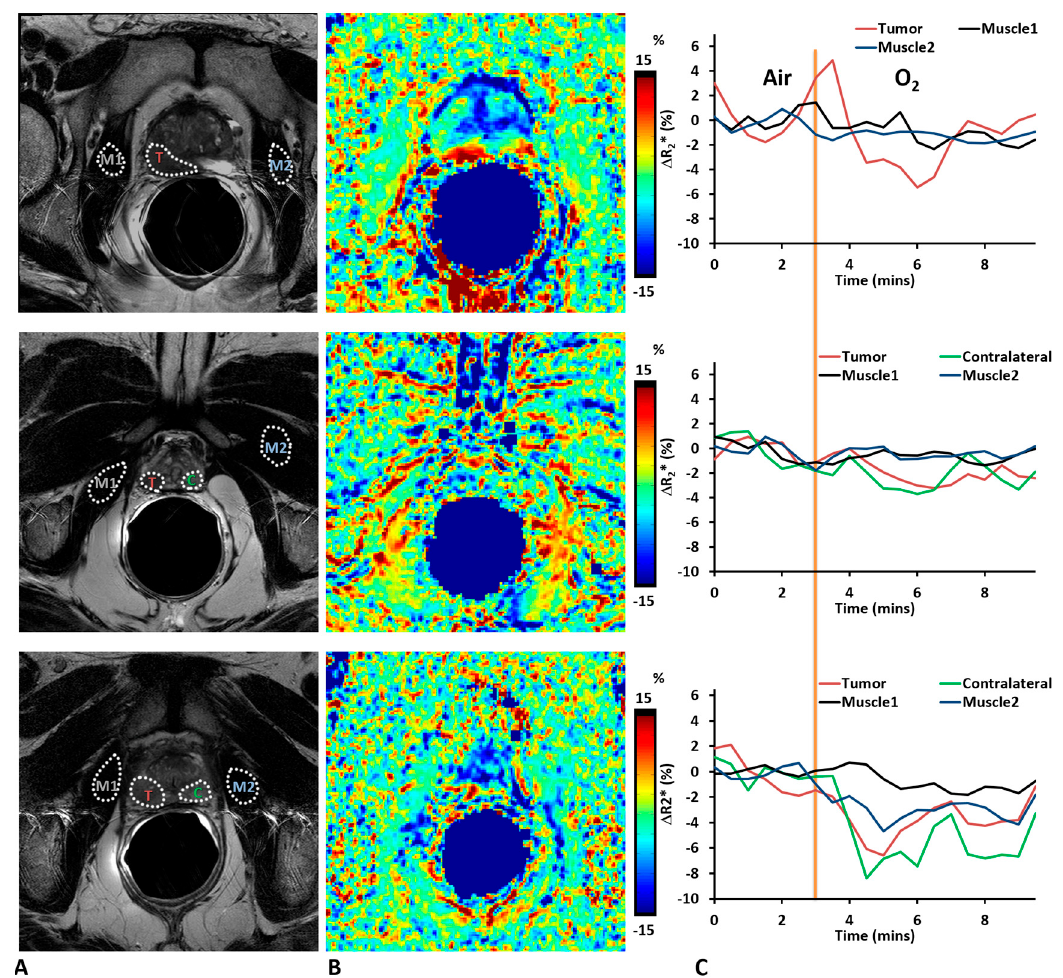
Figure 1. Oxygen-enhanced magnetic resonance imaging (MRI) of human prostate cancer. ( A ) T 2 w images showed hypointense tumor regions (T); ( B ) % Δ R 2 * maps (changes are normalized to baseline transverse relaxation rate (R 2 *) maps) for three representative tumors of Patients #3 (top), #5 (middle), and #6 (bottom) with Gleason scores 9, 7, and 8, respectively; ( C ) Traces of four regions of interest (ROIs, outlined in ( A ) with white dotted lines) showing dynamic changes of R 2 * in response to breathing oxygen (yellow line indicates start of oxygen breathing challenge). Tumor and normal prostate showed larger changes with oxygen breathing challenge compared to reference muscles. Labels in Figure ( A ): Tumor (T), Contralateral normal prostate (C), Reference Muscle 1 and 2 (M1 and